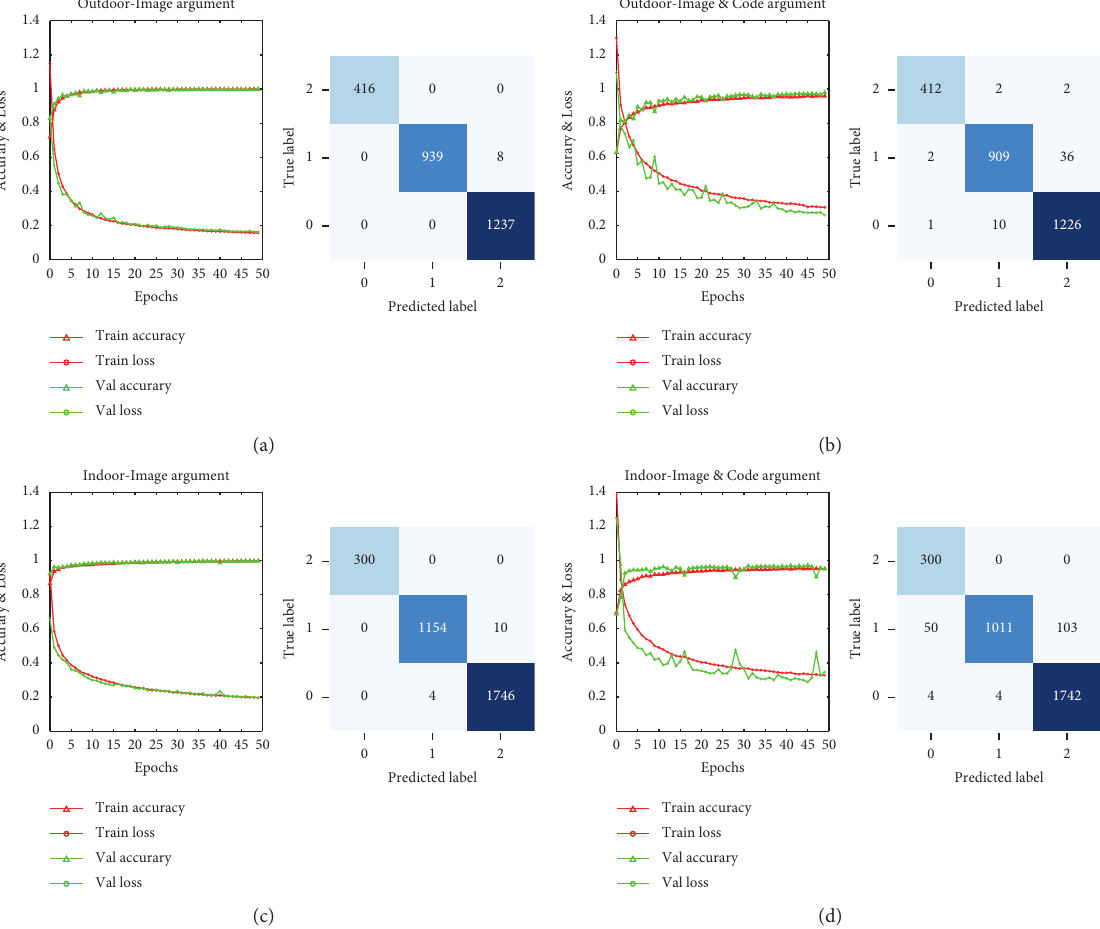
Figure 8: Image argumentation results for (a) outdoor without code, (b) outdoor with code, (c) indoor without code, and (d) indoor with